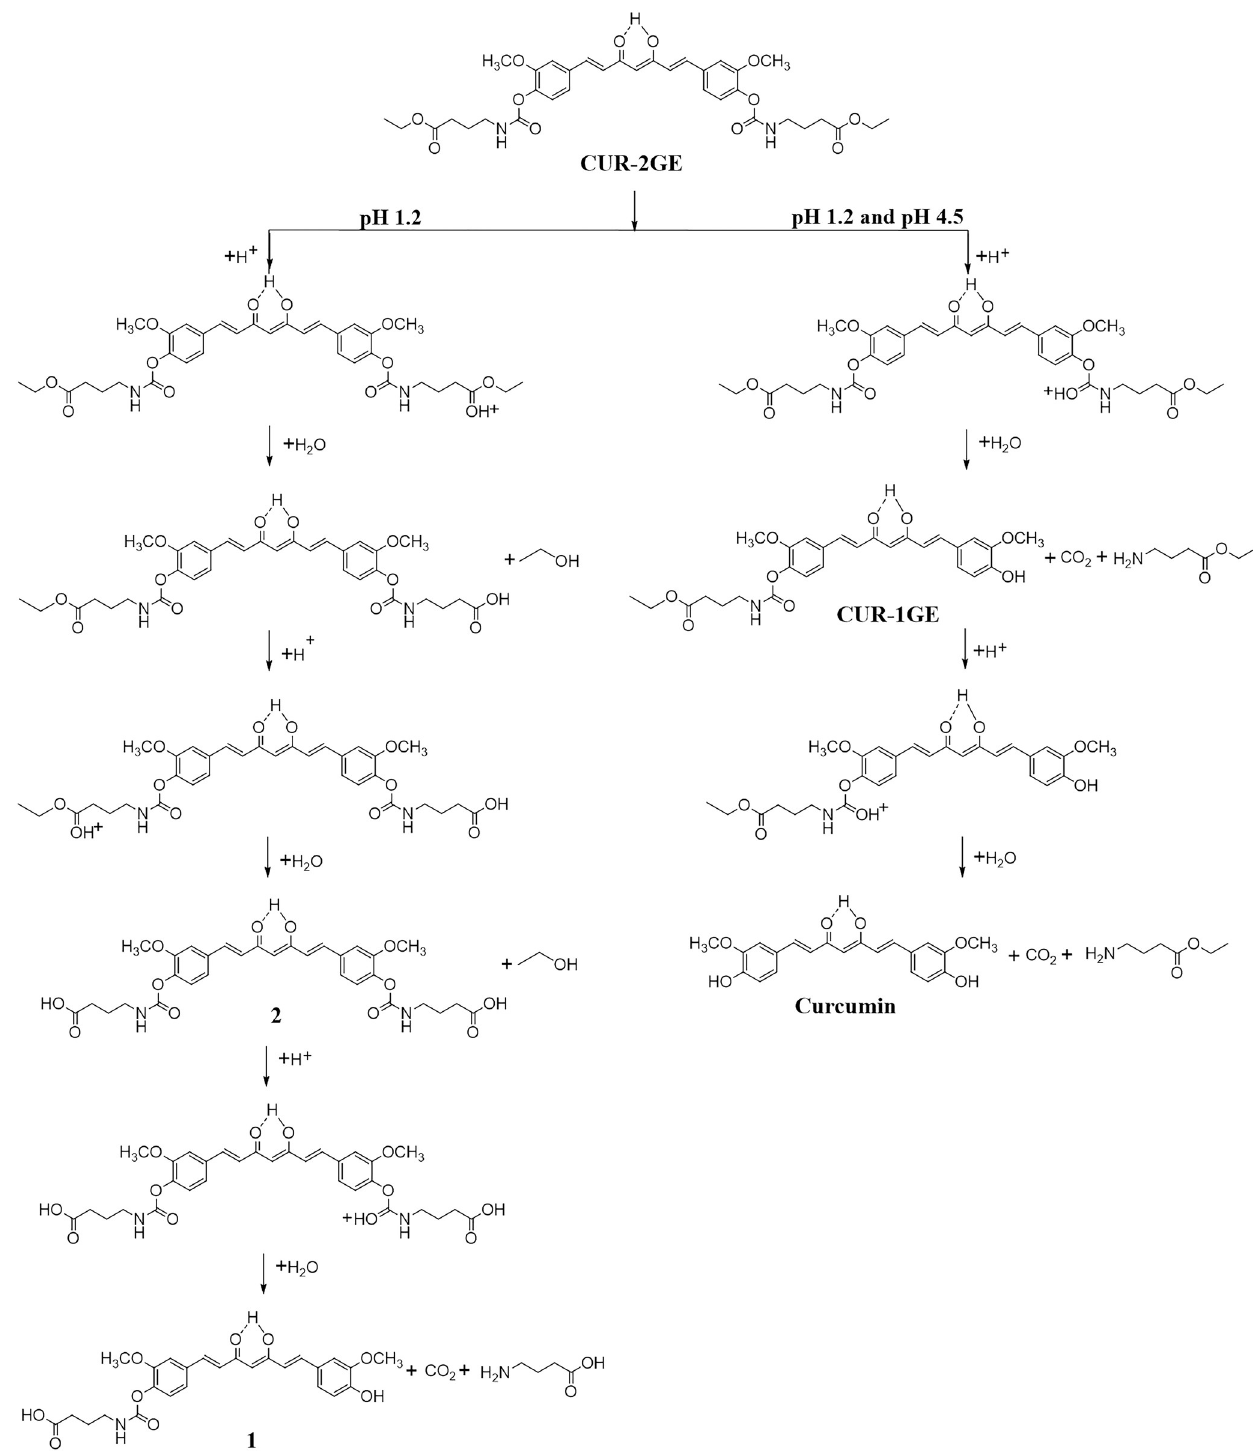
Fig 4. Proposed acid-catalyzed hydrolysis mechanisms of CUR-2GE in buffers at pH 1.2 and 4.5.